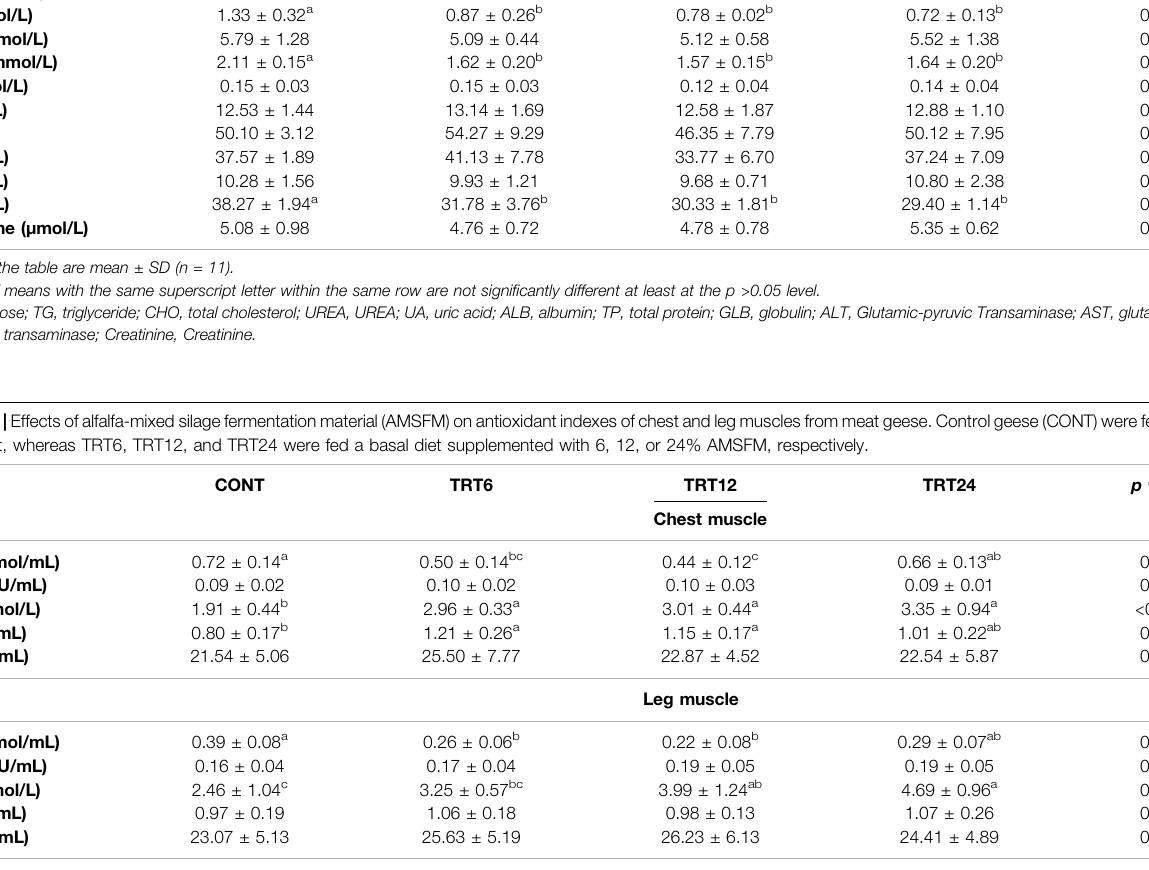
TABLE 6 | Effects of alfalfa-mixed silage fermentation material (AMSFM) on serum biochemistry of meat geese. Control geese (CONT) were fed a basal diet, whereas TRT6, TRT12, and TRT24 were fed a basal diet supplemented with 6, 12, or 24% AMSFM, respectively. Item